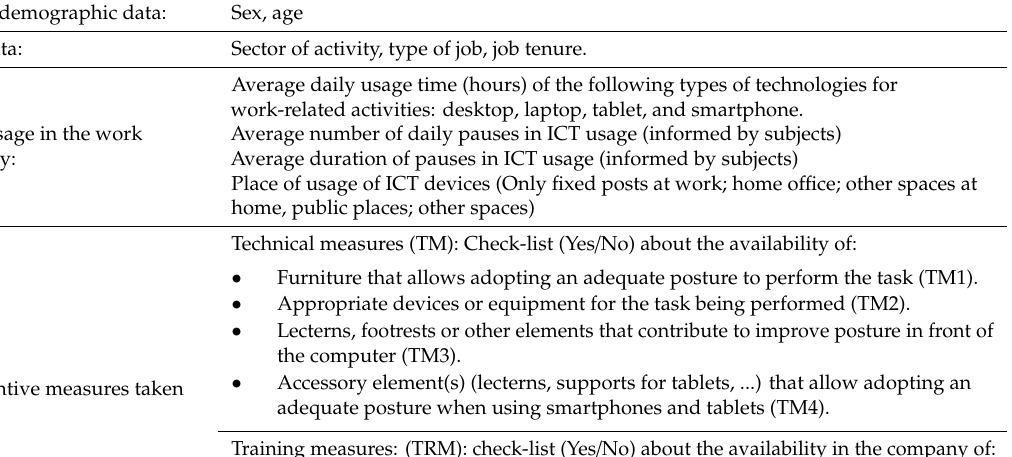
Table 1. Variables and